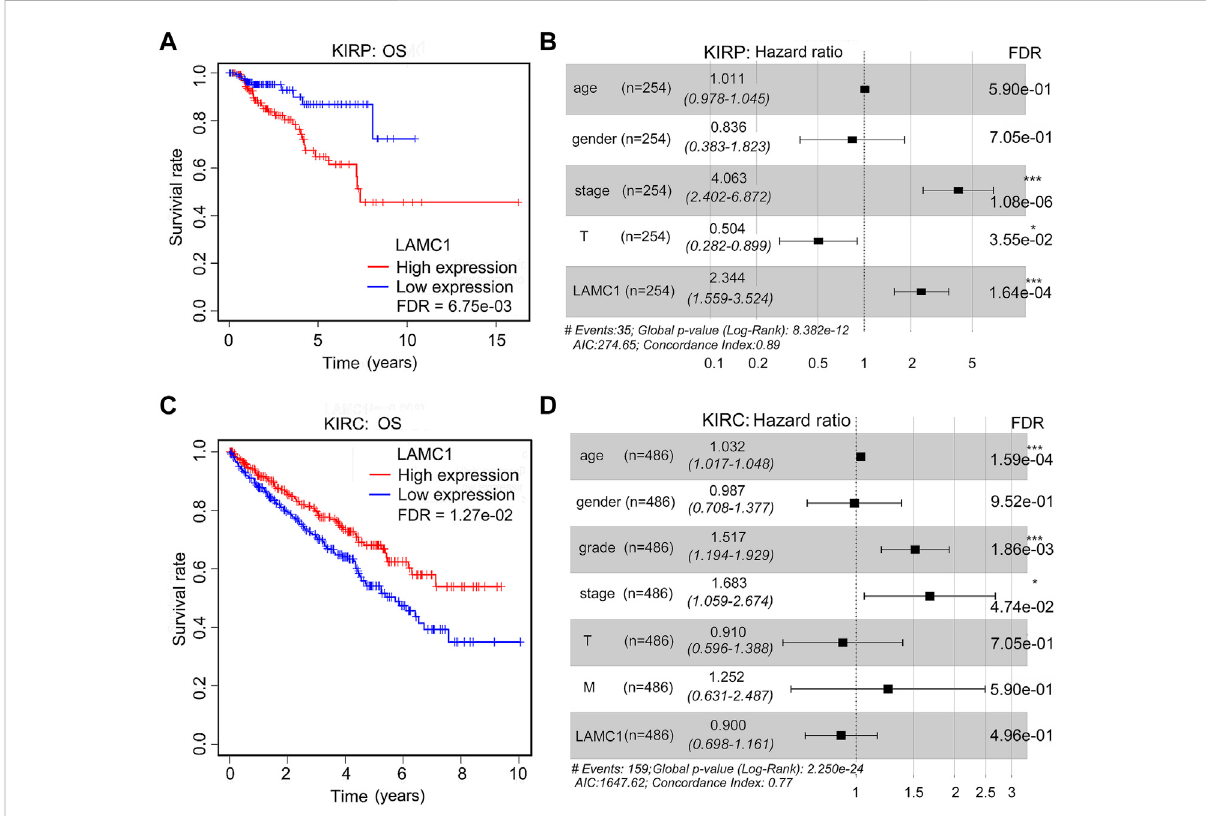
FIGURE 4 The prognostic signatures of LAMC1 and clinical parameters in KIRP and KIRC patients. Correlation of different expression of LAMC1 with survival (OS) of KIRP (A) and KIRC (C) patients. Survival data were analyzed using Kaplan-Meier method. High or low LAMC1 expression level was determinedinrelationtoitsmedianexpressionvalue.Theprognosticsignaturesof LAMC1 expressionandclinicalparametersinKIRP (B) andKIRC (D) patients in the multivariate Cox analysis model presented as the forest